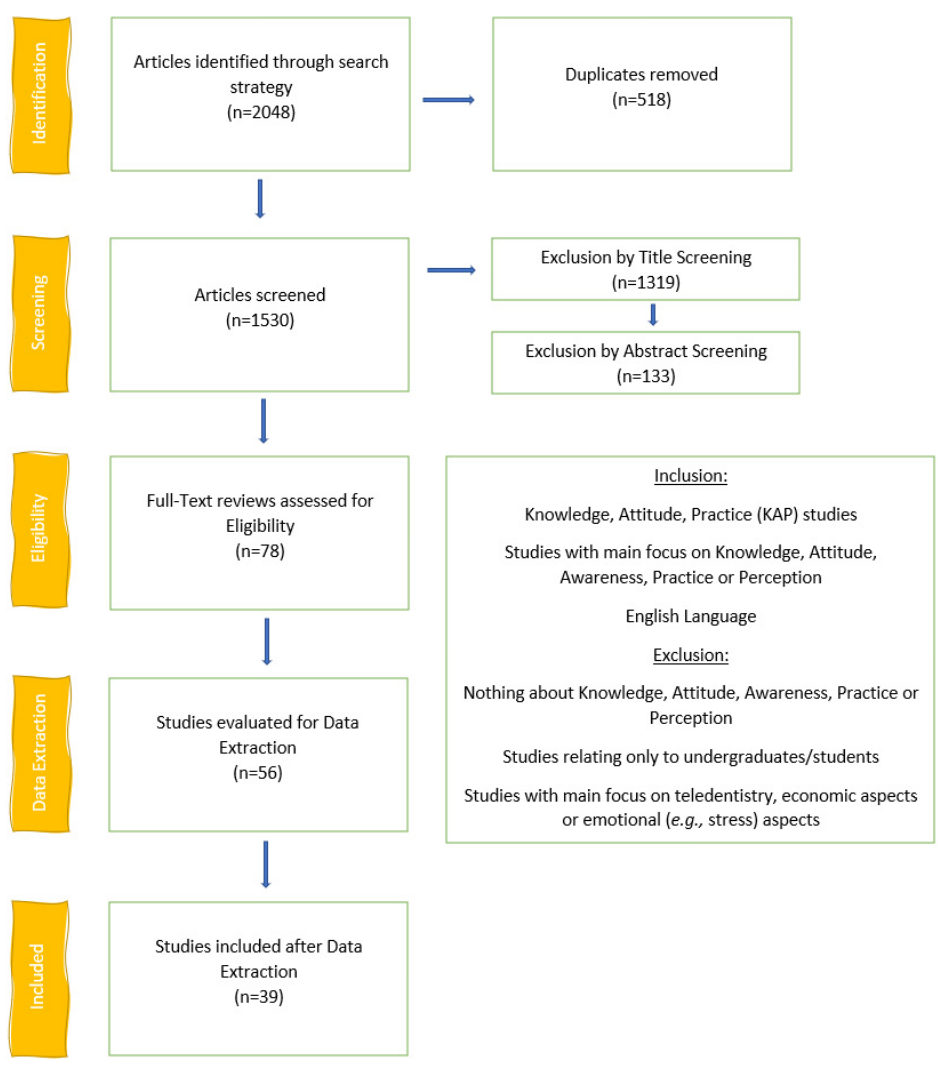
Figure 1. Flow Chart of the search procedure. Table 2. National surveys included sorted by Country, period of the surveys, Relative changes (%) COVID-19 cases and number of dentists participating in the surveys.